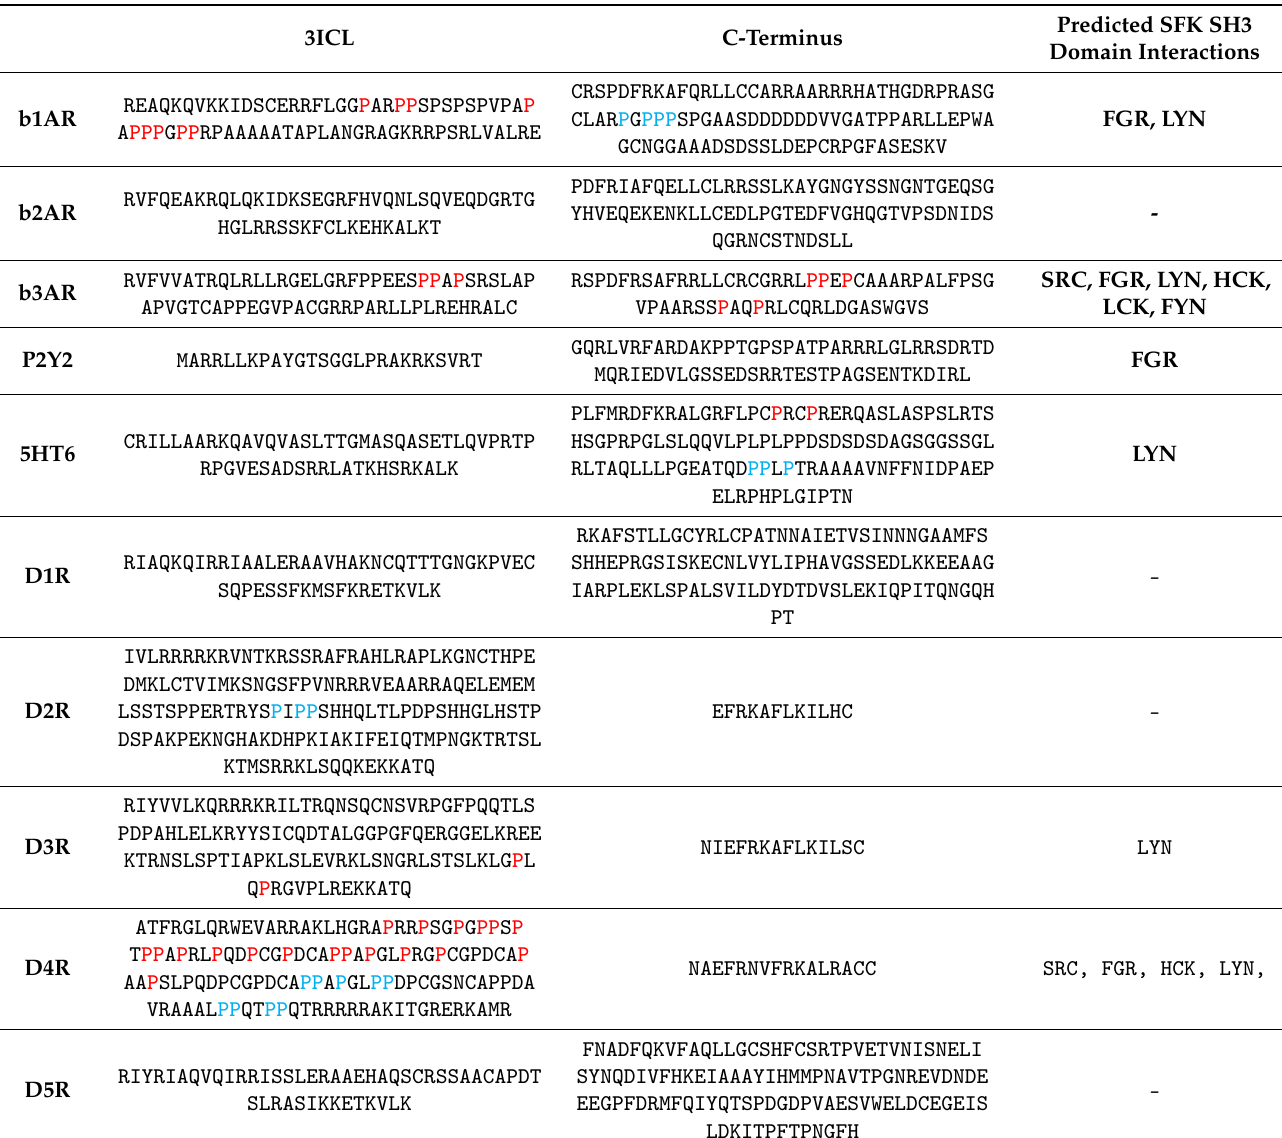
Table 2. Comparison of SFK binding motifs in the 3rd intracellular loop and C-tail of GPCRs. Shown are the amino acid Scheme 2. Y2 receptor, serotonin receptor type 6, and the subfamily of dopamine receptors, with highlighted polyproline motifs for SFKs in red and for other kinases in blue. Using a software to predict SH3 domain interactions, different SFK family members appeared to likely interact with individual domains